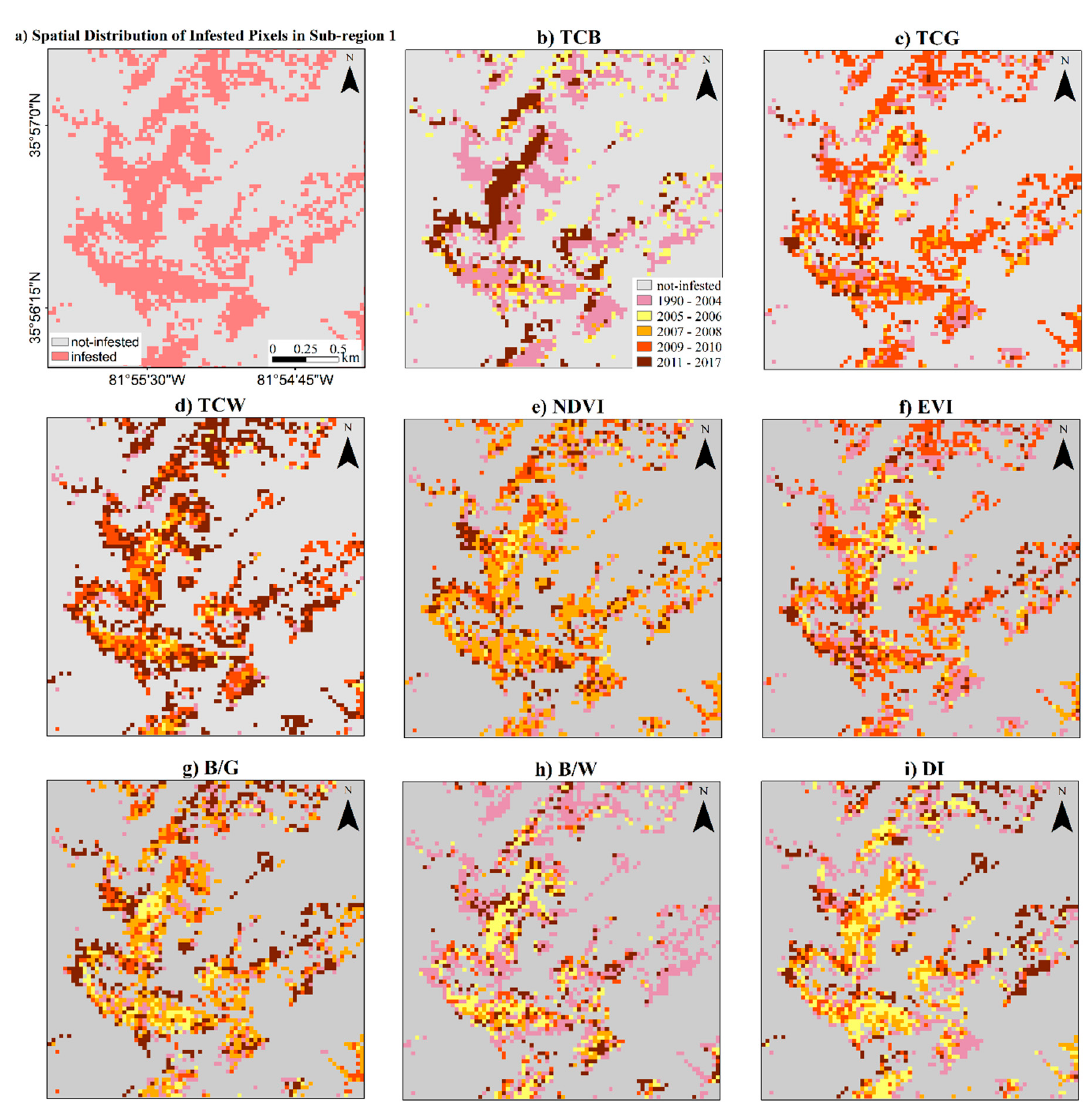
Figure 6. The spatial distributions of the maximum disturbance timing from eight spectral indices (Table 1) within sub-region 1 with 80 × 80 Landsat pixels (Figure 1). TCW and NDVI timing maps show the best agreements with the distribution of the infested pixels; however, the TCB and B/W timing maps show the weakest performance. The legend in map (b) applies to all maps.